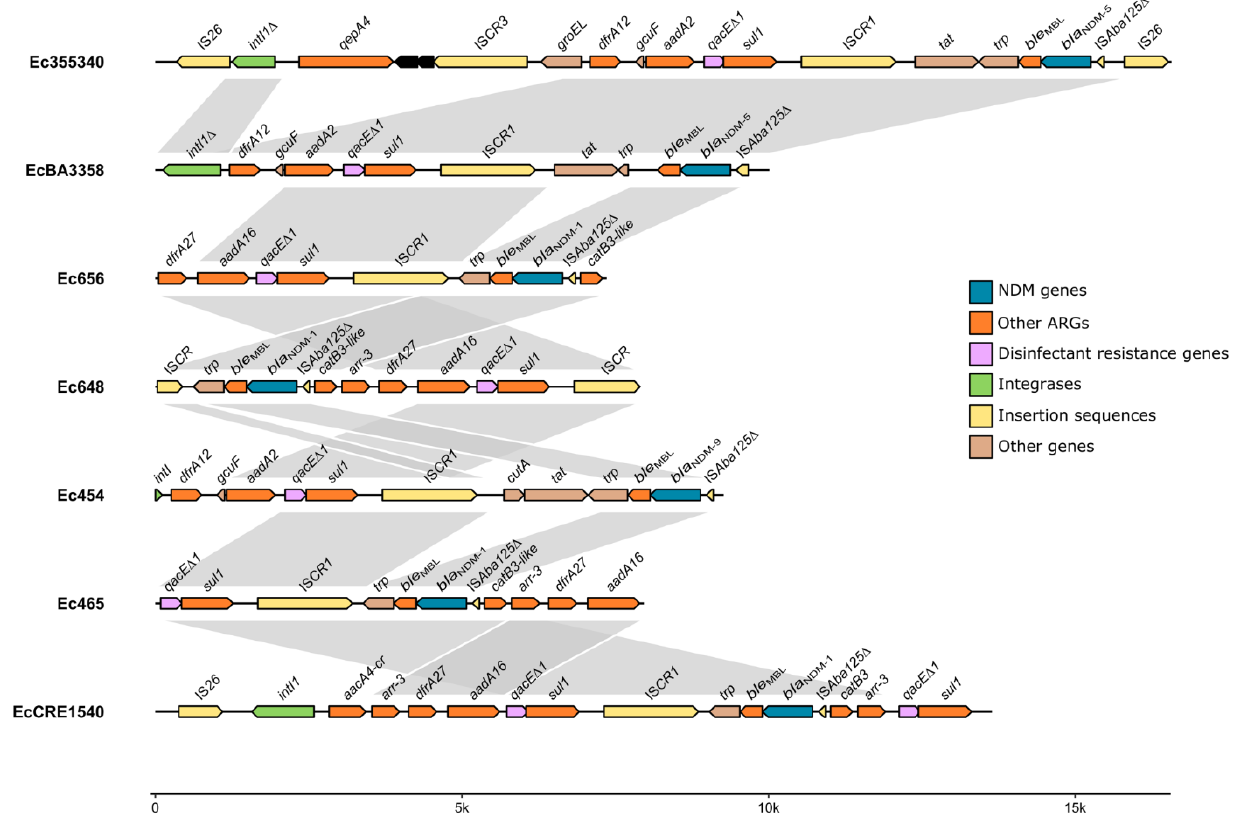
Figure 2. Schematic representation of the bla NDM -containing complex class 1 integron found in the clinical strain characterized in this study (Ec355340) and representative complex integrons identified in E. coli genomes affiliated to ST156 from PATRIC database (https://www.patricbrc.org/ accessed on 1 January 2022). This image was built using the R package gggenomes (https://github.com/ thackl/gggenomes accessed on 1 January